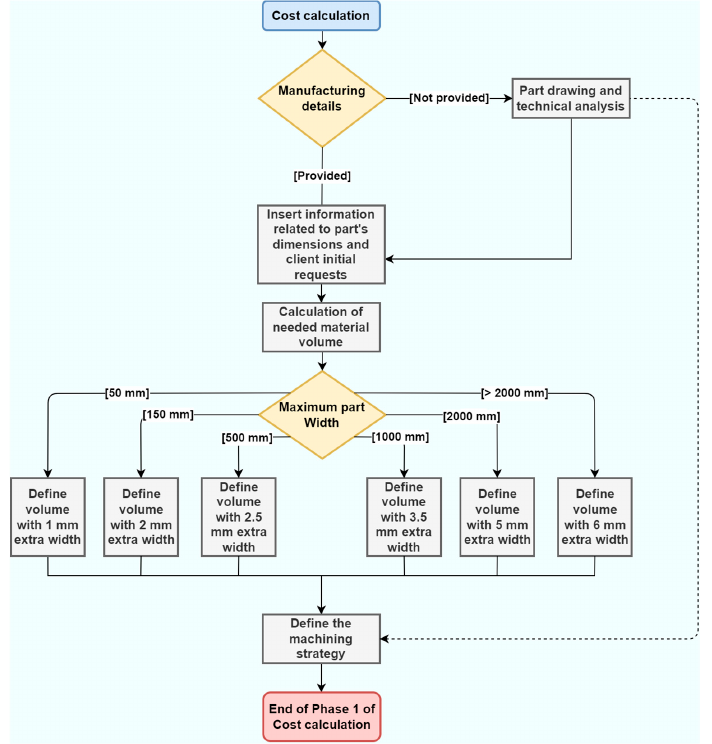
Figure 5. Flow chart of the developed model, for the first cost calculation step.